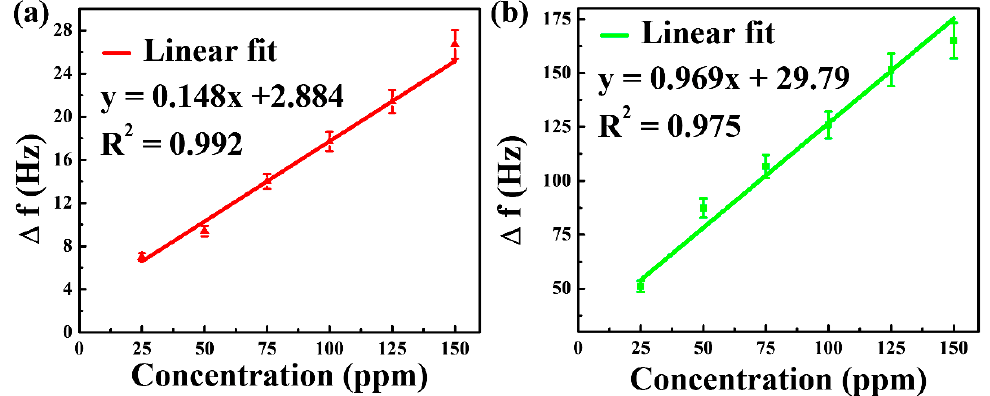
Figure 7. Linearity of ( a ) NGO@MnO 2 and ( b ) NGO@MnO 2 /PPy in the QCM sensor ( T = 20 ◦ C, R.H. = 25–30%). Table 1. Data of the calibration curve for the QCM sensor method.